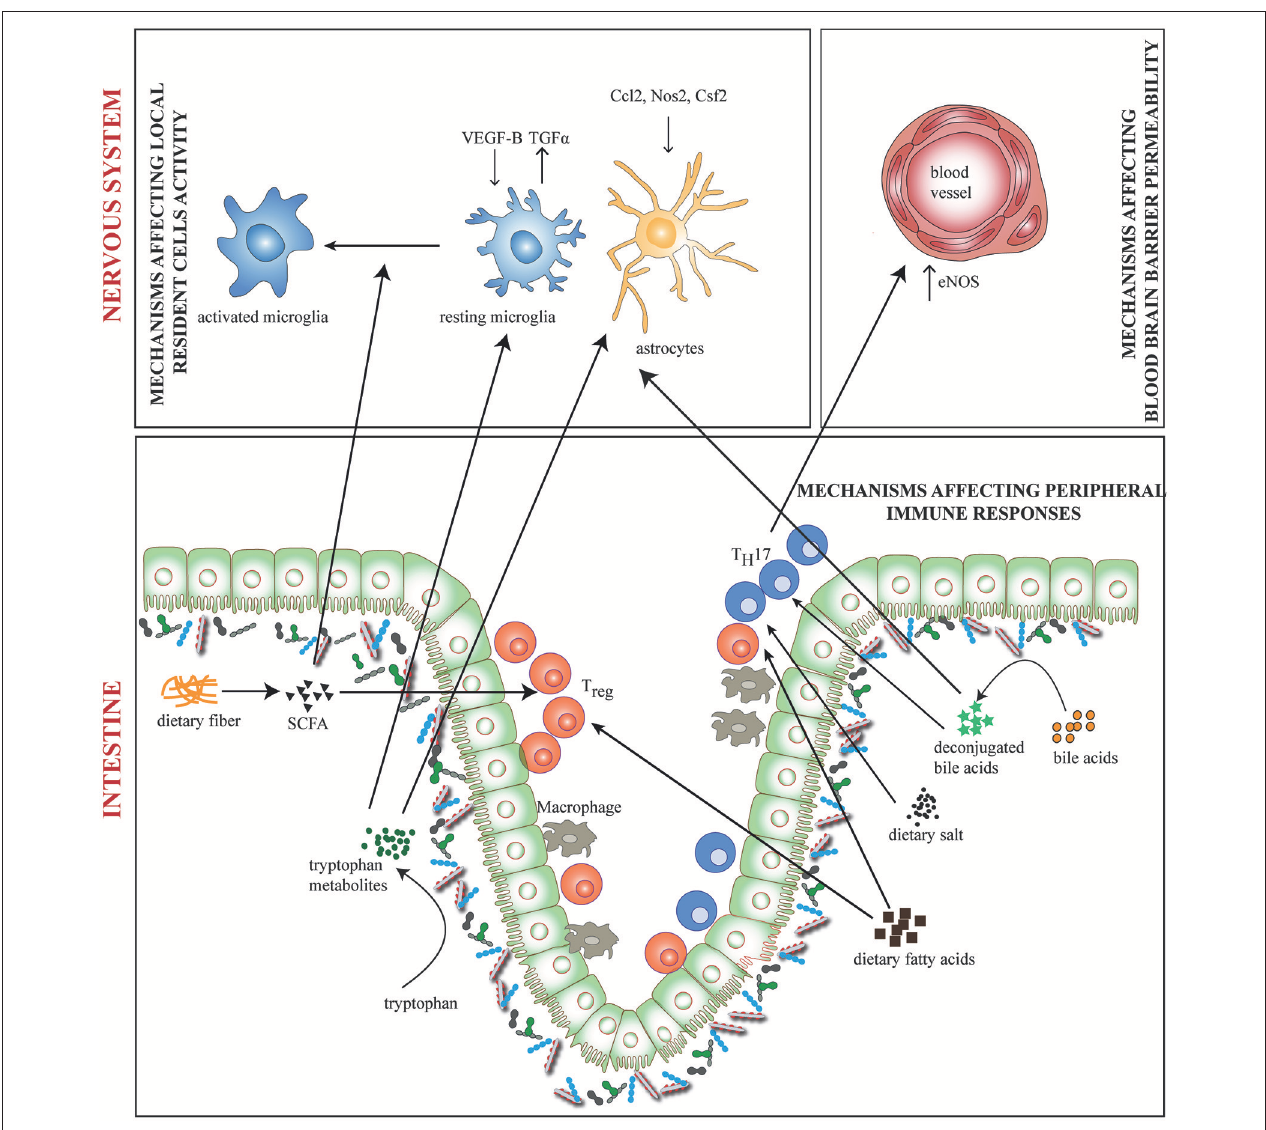
FIGURE 1 | Diet-Microbiome interactions in neuroinflammation. Gut microbiota and dietary metabolites contribute to neuroinflammation through direct and indirect ways. Dietary fiber and tryptophan are modified by the microbiome to generate metabolites such as short chain fatty acids (SCFA) and indole derivatives which affects functional activity of local resident cells—the microglia and astrocytes. Tryptophan metabolites regulate the production of pro-and anti-inflammatory mediators like VEGF-B and TGF- α on microglia and Nos2, Ccl2, and Csf2 on astrocytes. SCFAs regulate the activation of microglia. In addition, bile acids, SCFAs, dietary salt and fatty acids directly induce differentiation of either T H 17 or T reg cells. This may result in altered activity of inflammation associated molecules. T H 17 cells upregulate eNOS in CNS endothelia lining the blood vessels, thus altering blood brain barrier permeability. Bile acids may also penetrate the CNS and affect the activity of resident